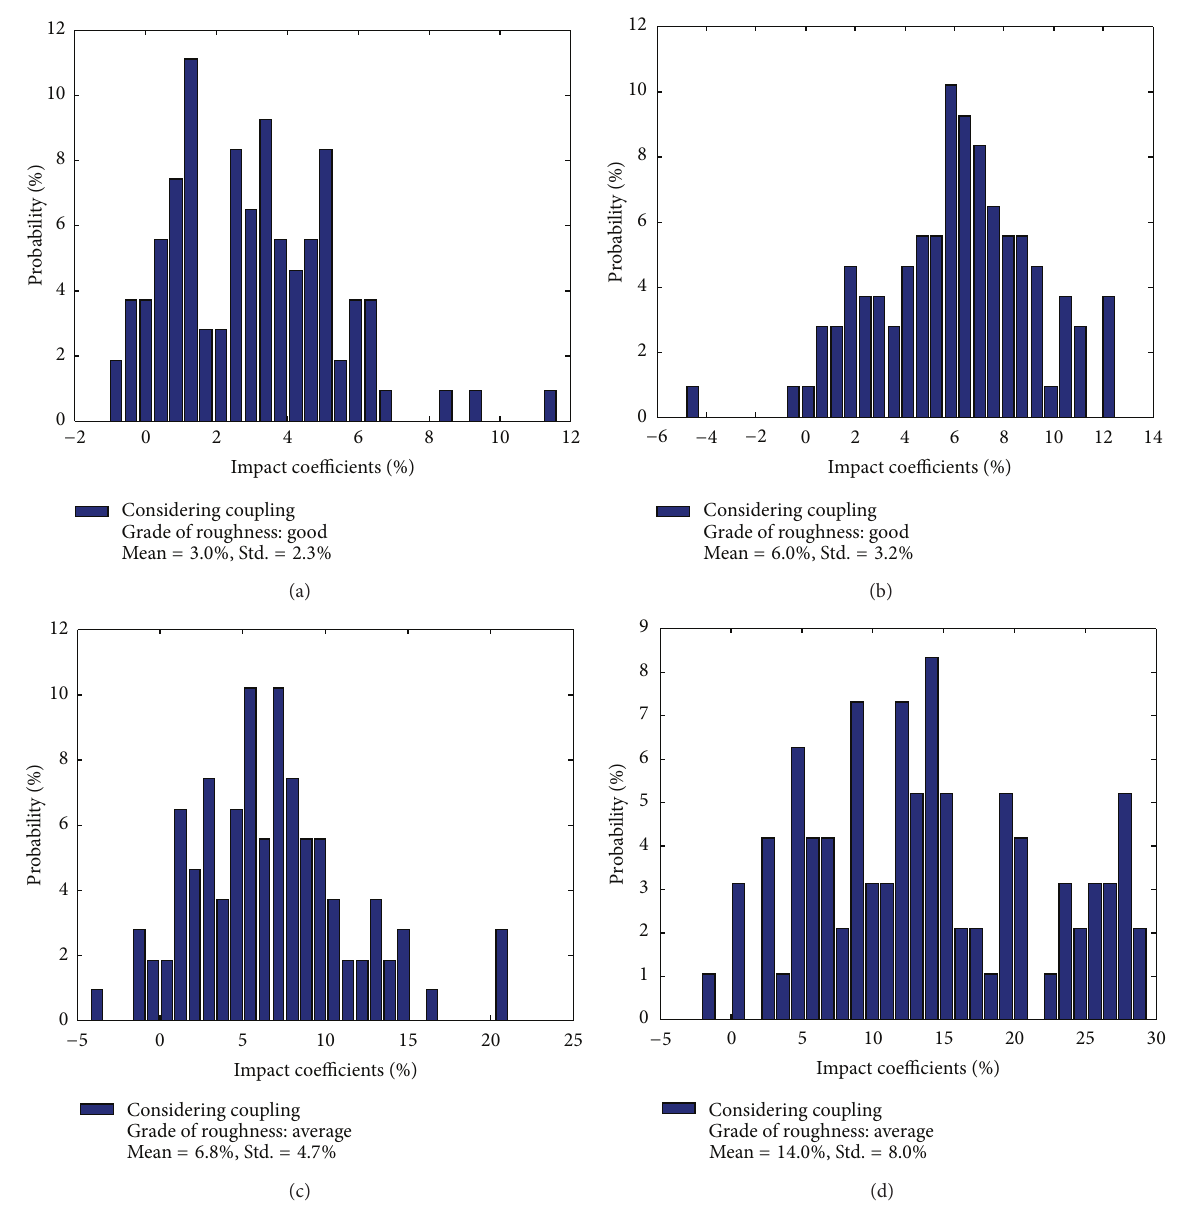
Figure 15: Probabilistic distributions of vertical displacement impact coefficients at point A of the bridge at different traveling velocities: (a) 80 km/h; (b) 120km/h; (c) 80 km/h; (d) 120km/h.